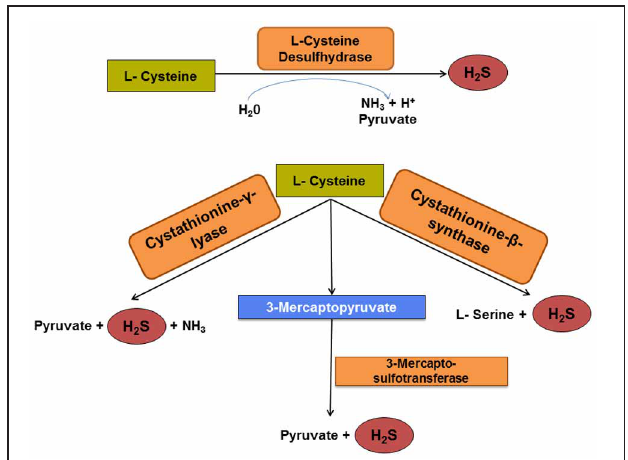
FIGURE 3 | Pathways of cysteine degradation to H 2 S. Cysteine desulfhydrase is a key enzyme for initial microbial cysteine fermentation and pyruvate production. However, recent evidence indicates that three other enzymes orthologous to eukaryotic enzymes may catalyze similar reactions. The generation of H 2 S via these four enzymatic pathways may surpass that by dissimilatory sulfate reduction, especially in hosts consuming a protein-rich diet.